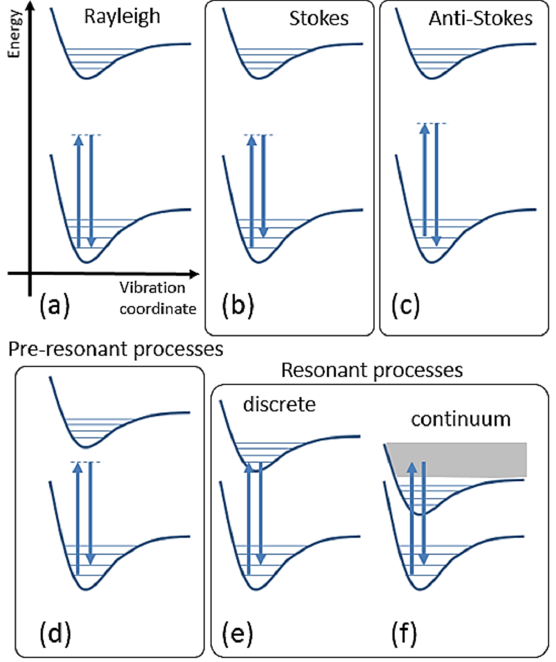
Figure 4. Jablonski diagram of Rayleigh scattering ( a ), non ‐ resonant Stokes ( b ) and anti ‐ Stokes ( c ) Raman scattering, and pre ‐ resonant ( d ) and resonant Raman scatterings ( e , f ).